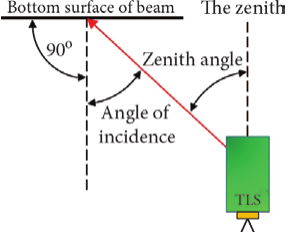
Fig. 6. Angle of incidence at scanning, the red line indicates the laser